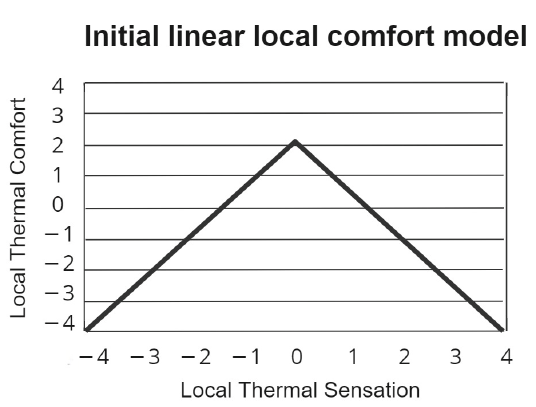
Figure 4. Relation between thermal comfort and thermal sensation.